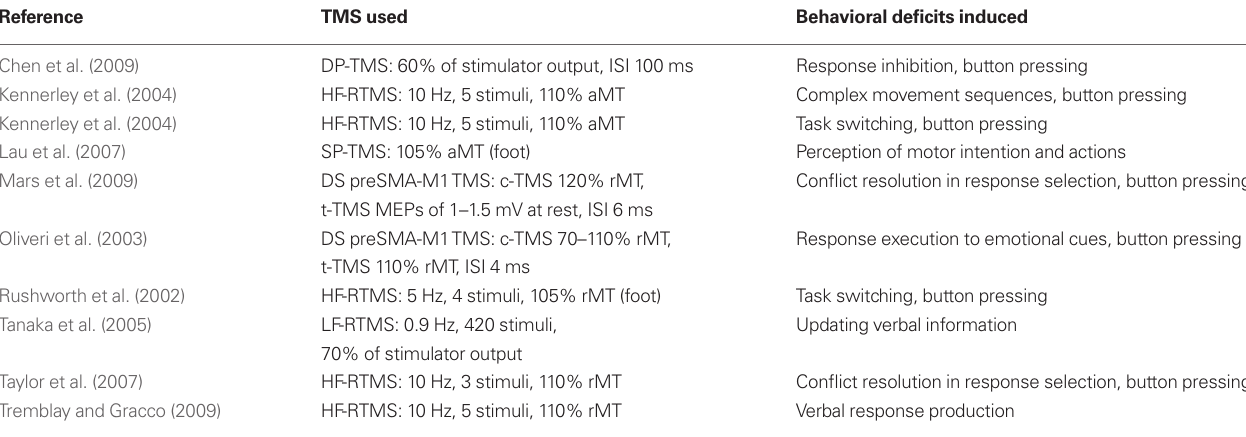
Table 4 | TMS studies of pre-SMA.